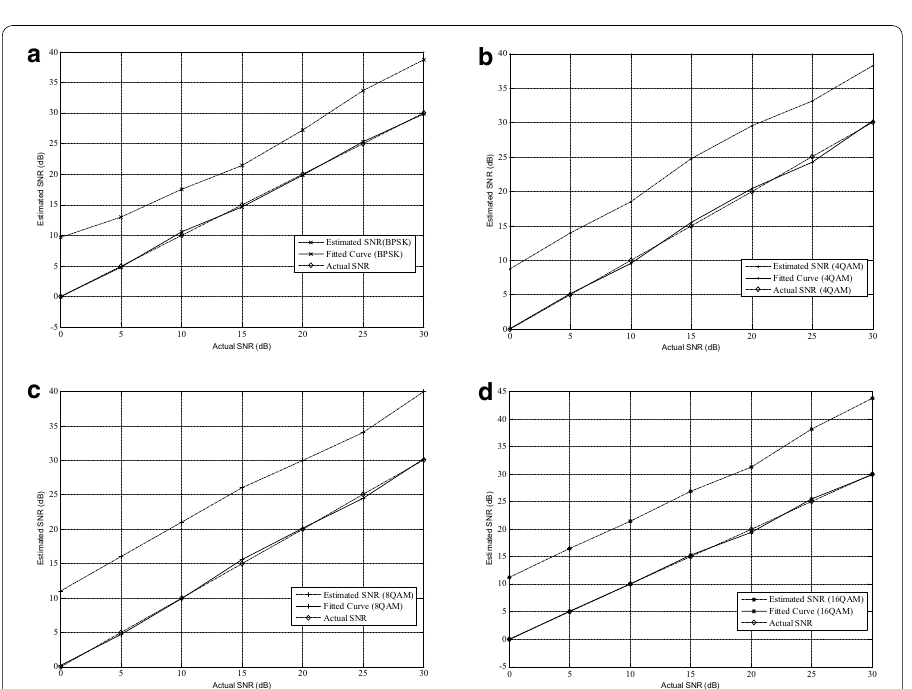
Fig. 4 Estimated SNR versus actual SNR. a Comparison under BPSK modulation, b comparison under 4QAM modulation, c comparison under 8QAM modulation, d comparison under 16QAM